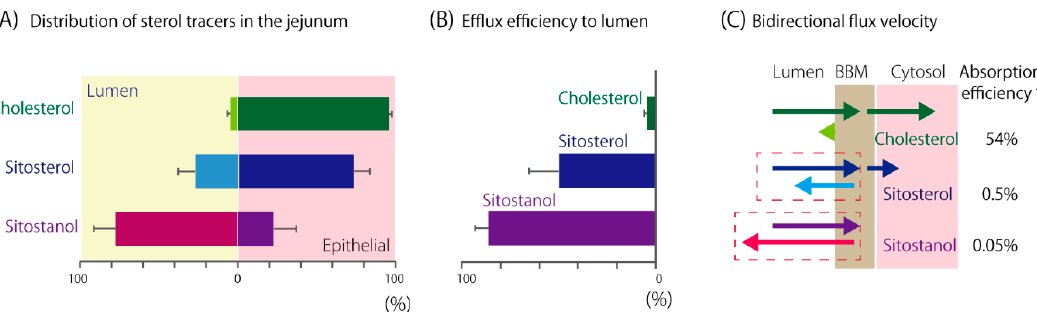
Figure 4. ( A ) Tracer distribution in the murine jejunum 3 h after oral infusion. Tracers in the luminal flush and in the intestinal segment are shown in percent of the total. Data were obtained from the studies conducted in Reference [54] and were reanalyzed. Assay replication: cholesterol, n = 10; sitosterol, n = 6, sitostanol, n = 11. ( B ) Percentages of effluxed tracers from the mucosa for 1 h during cannulated jejunal perfusion. Assay replication: cholesterol, n = 10; sitosterol, n = 6; sitostanol, n = 6. Similar tendency was also reported in mice by an independent research group [94]. ( C ) The diagram shows cholesterol or PS fluxes at the BBM. The lengths of the arrows indicate the supposed flux velocity. Dashed boxes indicate where PS-shuttling takes place. Data are shown as mean and standard deviation. *Absorption efficiency in humans was obtained from [95] for cholesterol and [96] for PSs.